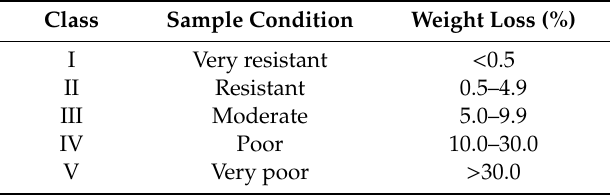
Table 3. Classification of wood resistance against fungal